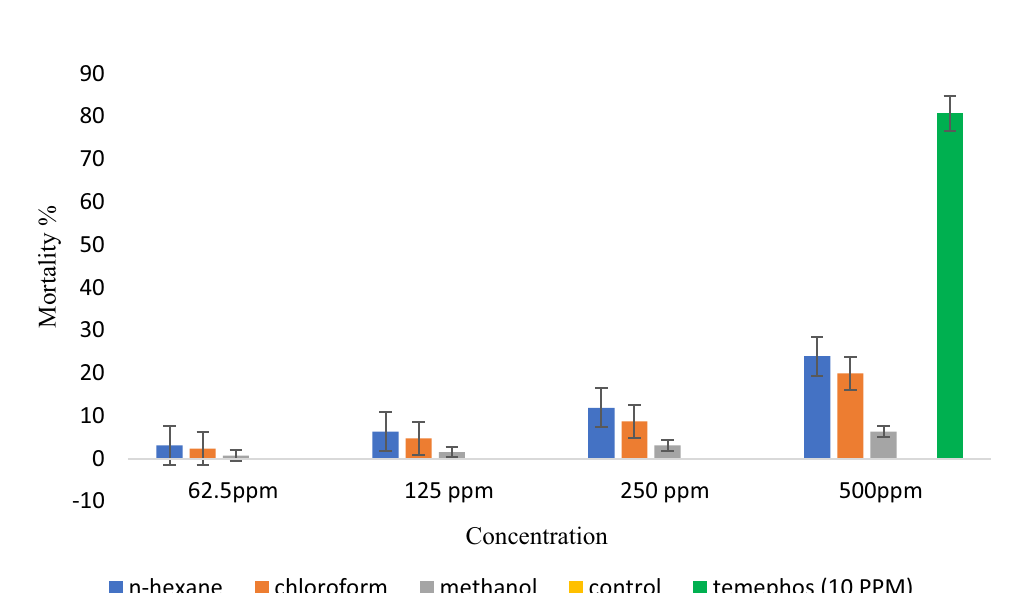
Fig. 1 Percentage ovicidal activity of crude extracts of leaves of P. pterocarpum against Ae. aegypti eggs